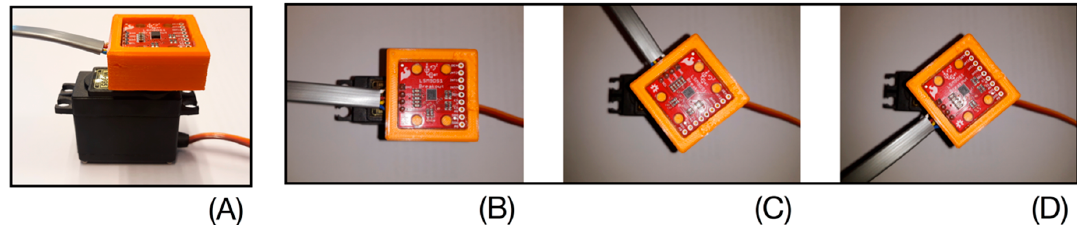
Figure 4. ( A ) Servo motor + housing adapted to its axis to fix the MARG. ( B ) Angle = 0°, ( C ) Angle = +30°, ( D ) Angle = − 30°.